Question: Give a one-sentence summary of this figure.
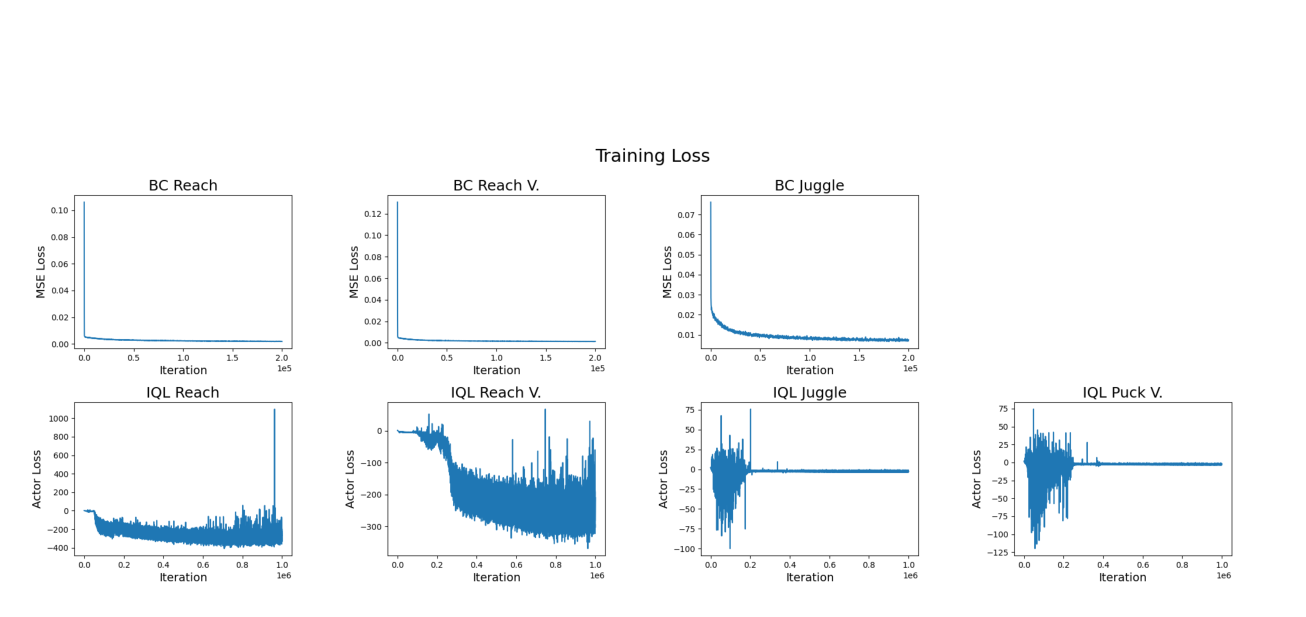
Answer: Loss (MSE of behavior cloning and Actor Loss for IQL) curves for training using data collected from the real robot. Since humans did not distinguish puck velocity and juggling, we only trained a single behavior cloning policy (BC Juggle).